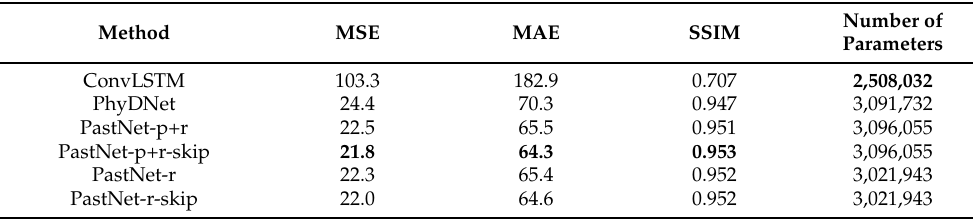
Table 2. Comparison of different versions of PastNet and baseline methods on Moving MNIST. All networks were trained on the dataset for 2000 rounds with a batch size of 64. All PastNet models outperformed ConvLSTM and PhyDNet, with slightly more parameters. PastNet-p+r-skip gained the best MSE, MAE, and SSIM.